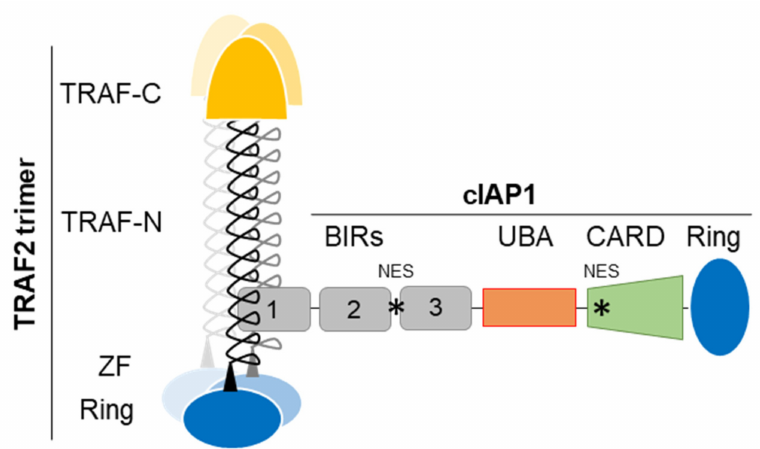
Figure 1. cIAP1-TRAF2 E3-Ubiquitin ligase complex, schematic representation. TRAF-N, TRAF-C, Zing finger (ZF), RING, BIRs (Baculoviral IAP repeat), UBA (ubiquitin-associated), CARD (caspase recruitment) domains and NES (Nuclear export signal) are represented. cIAP1-TRAF2